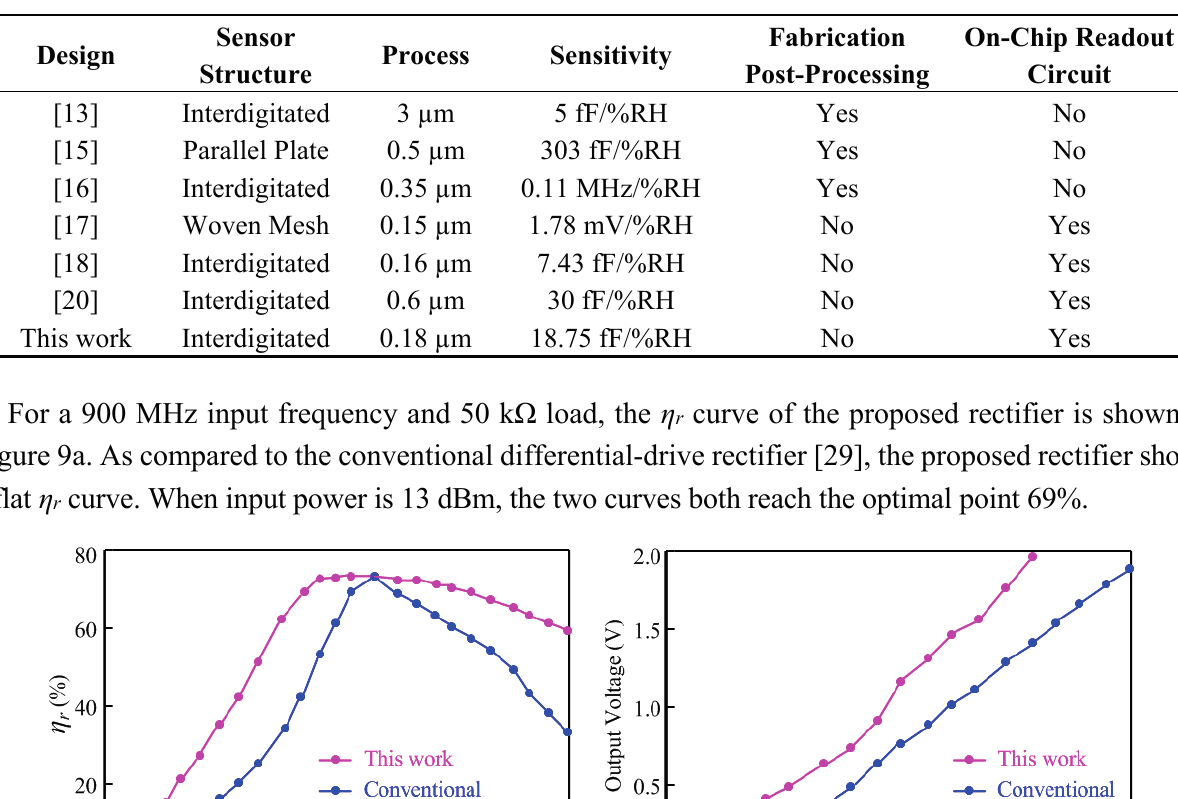
Table 1. Comparison of integrated humidity sensors.